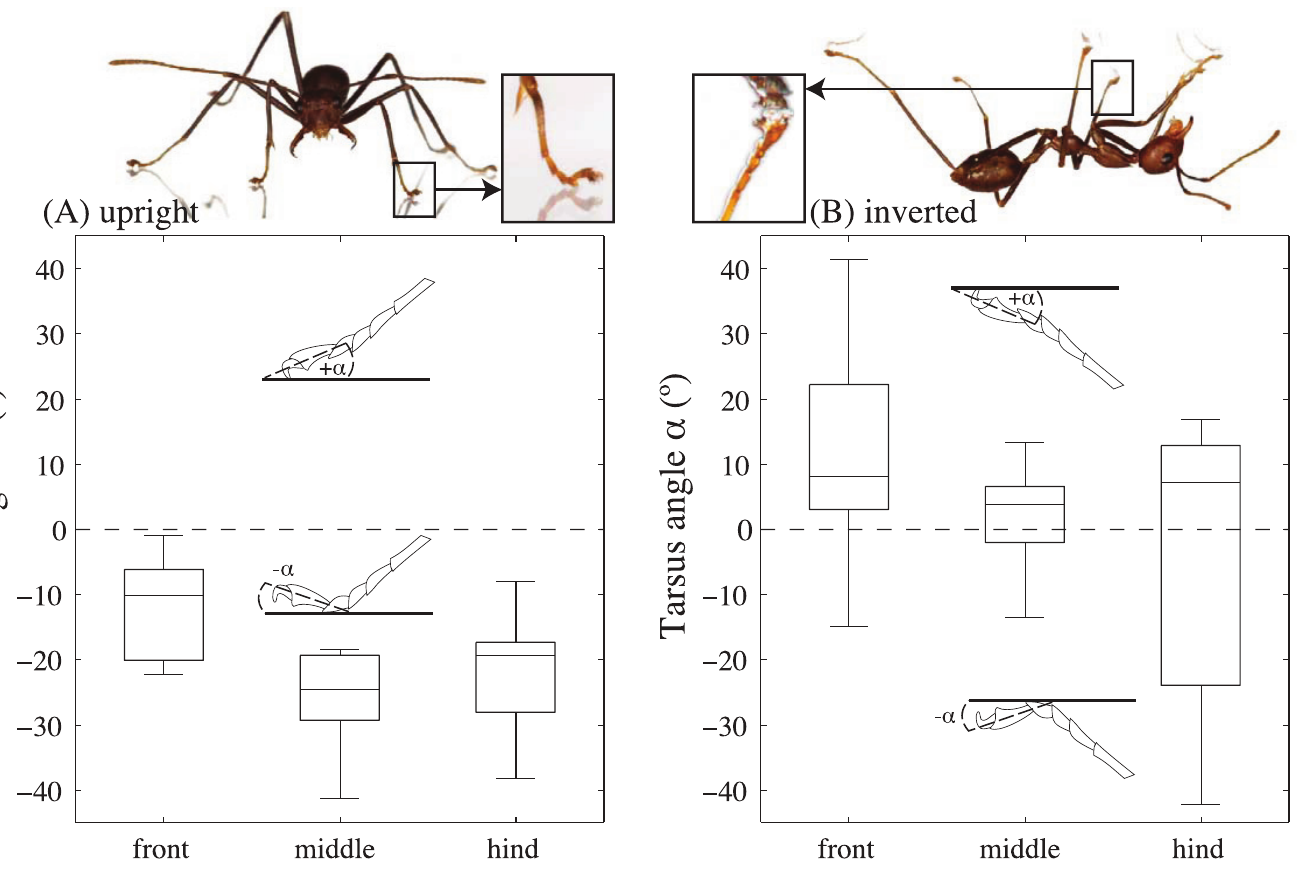
Fig 2. Tarsomere angle of freely walking weaver ants. (A) Level walking. Here, the ants stood mainly on their 3 rd and 4 th tarsomeres and held the 5 th tarsomeres away from the substrate (5 th tarsomere angle < 0°; see photo). (B) Inverted climbing. Here, the 5 th tarsomere angle of was mostly positive, allowing the adhesive pad (arolium) to make contact (see also